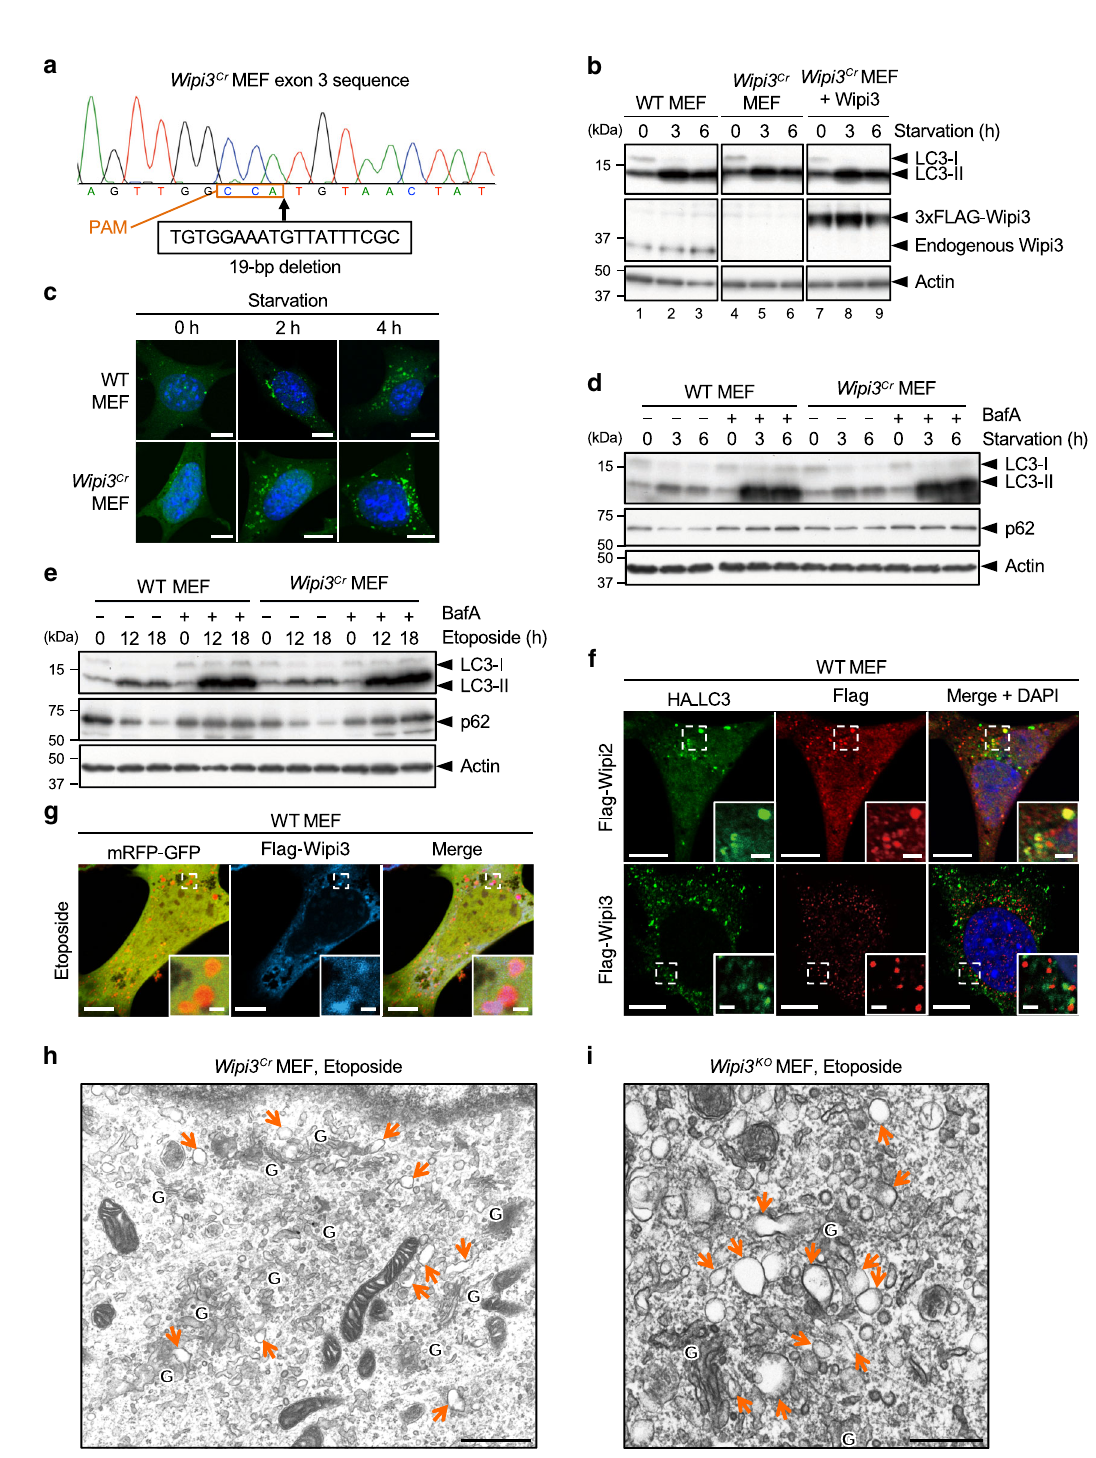
Fig. 5 Effects of Wipi3 on VSVG traf fi cking upon etoposide treatment. a Schematic diagram of the experiment. VSVG – GFP-expressing Atg5 KO MEFs and Atg5 KO /Wipi3 Cr MEFs were treated with or without etoposide (10 µ M) at the restrictive temperature (40 °C) for 12 h. Cells were then shifted to the permissive temperature (32 °C), and fi xed at the indicate times. b Representative images at 0, 15, and 60 min after the temperature shift are shown. Golgi were stained with an anti-GS28 antibody, and the location of VSVG-GFP and Golgi were analyzed. Scale bars = 10 µ m. c Reduction of PM-localized VSVG – GFP upon etoposide treatment in Atg5 KO MEFs. The Atg5 KO MEFs containing VSVG-GFP were or were not treated with etoposide, and at 60 min after the temperature shift, PM-localized VSVG-GFP was stained with an anti-VSVG antibody, and its amount was measured using fl ow cytometry. d The indicated MEFs containing VSVG-GFP were treated with or without etoposide (10 µ M) in the presence of E64d and pepstatin. At 60 min after the temperature shift, cells were immunostained with an anti-Lamp2 antibody. Bars = 10 µ m. Magni fi ed images of the dashed squares are shown in the insets. Bars = 1 µ